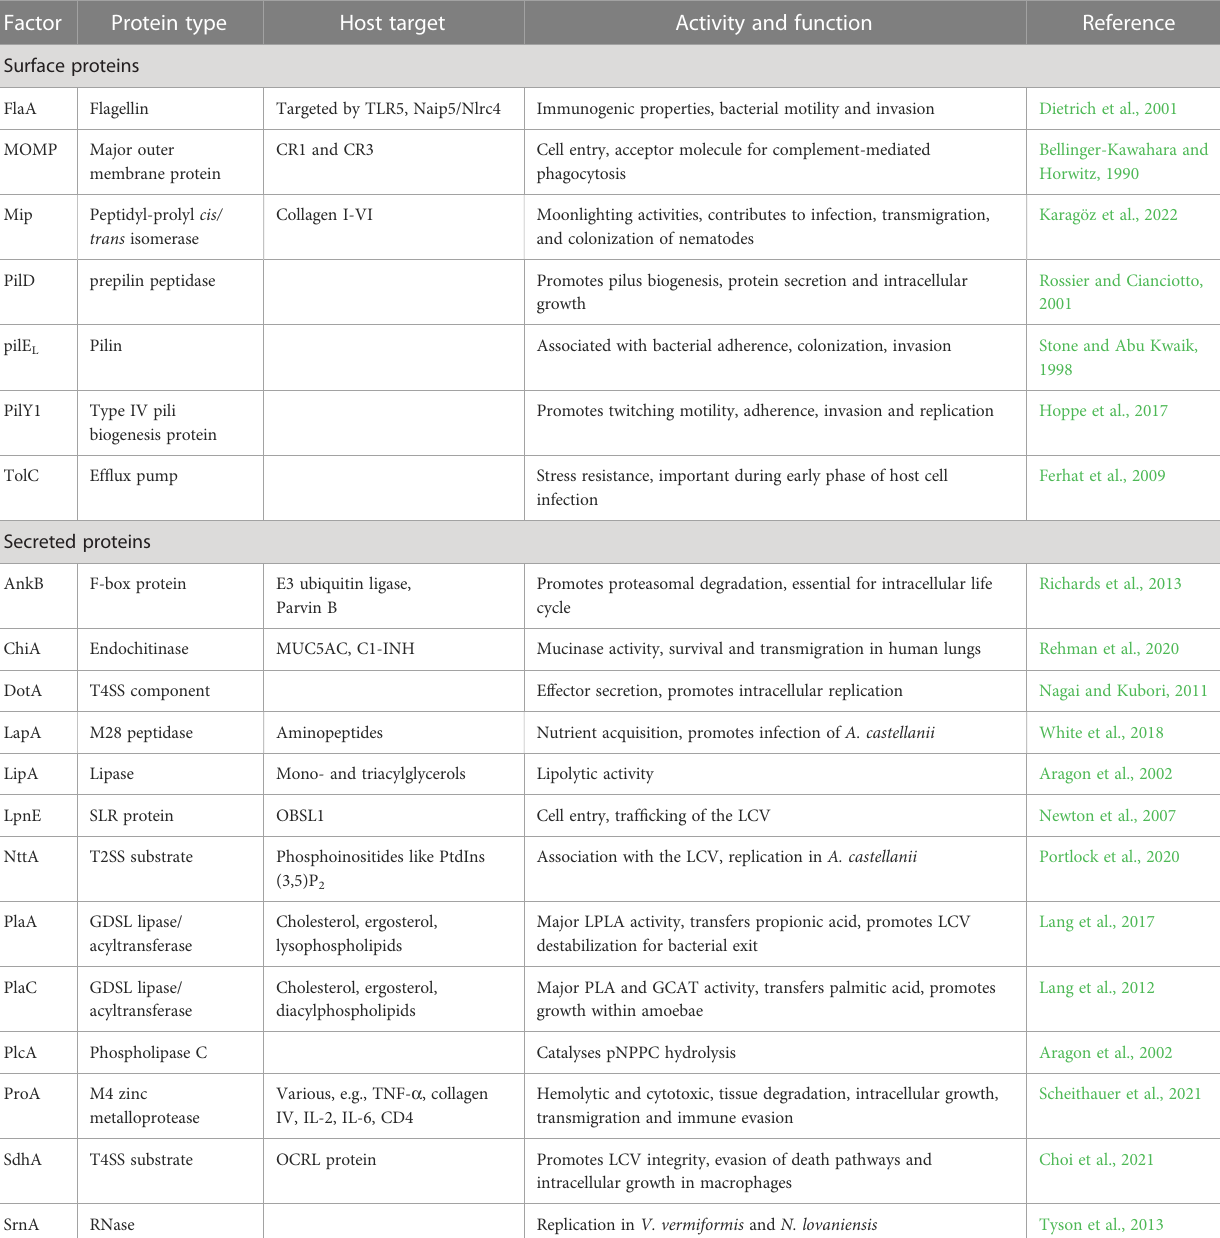
TABLE 1 Surface-associated and secreted proteins of L. pneumophila and their extra- and intracellular host targets addressed in this